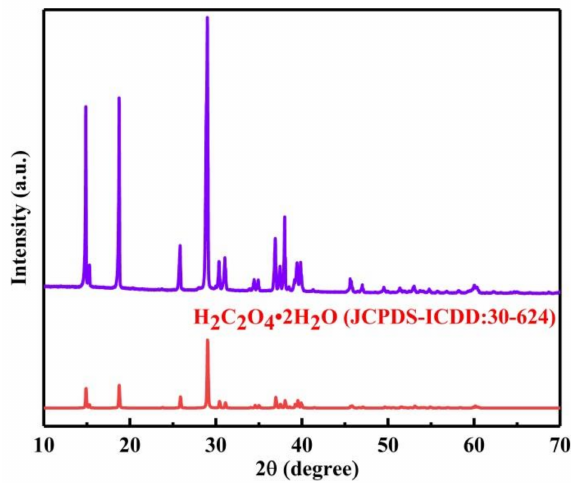
Figure 1. XRD pattern of the precipitate by cooling crystallization.